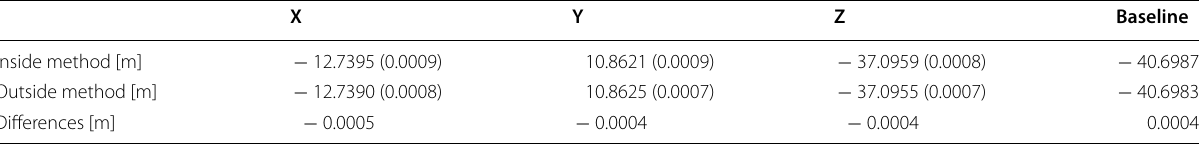
Table 3 VLBI–GNSS local-tie vectors estimated by inside and outside methods. Values in parenthesis represent measurement errors X